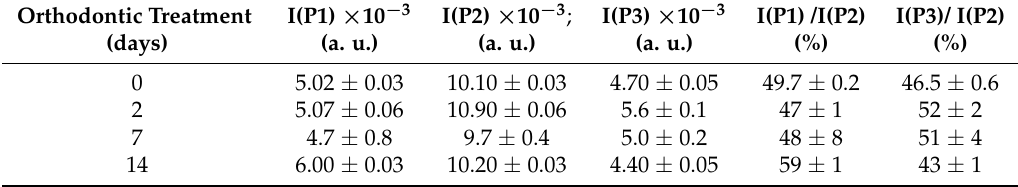
Figure 7. Deconvolution of the Raman spectra of PDL samples in the 2800–3000 cm − 1 spectral region. Measured spectra, black lines; main P1, P2 and P3 Lorentzian components of the Raman band, blue lines. Gray lines refer to the fit of the experimental data resulting from the deconvolution process. Data were obtained by averaging the Raman response of PDL samples from ( a ) control, and samples after ( b ) 2, ( c ) 7, and ( d ) 14 days of orthodontic force application. All the band areas were normalized to 1 and spectra in ( b – d ) were compared with Raman response (red line) of controls ( a ). Table 4. Deconvolution of Raman spectra of PDL samples in 2800-3000 cm − 1 region. Raman signal intensities for main components (P1, P2, and P3) and ratios of P1 and P3 component intensities compared to P2 one (in percentage) reported at different stages of OTM. Raman band areas were normalized to